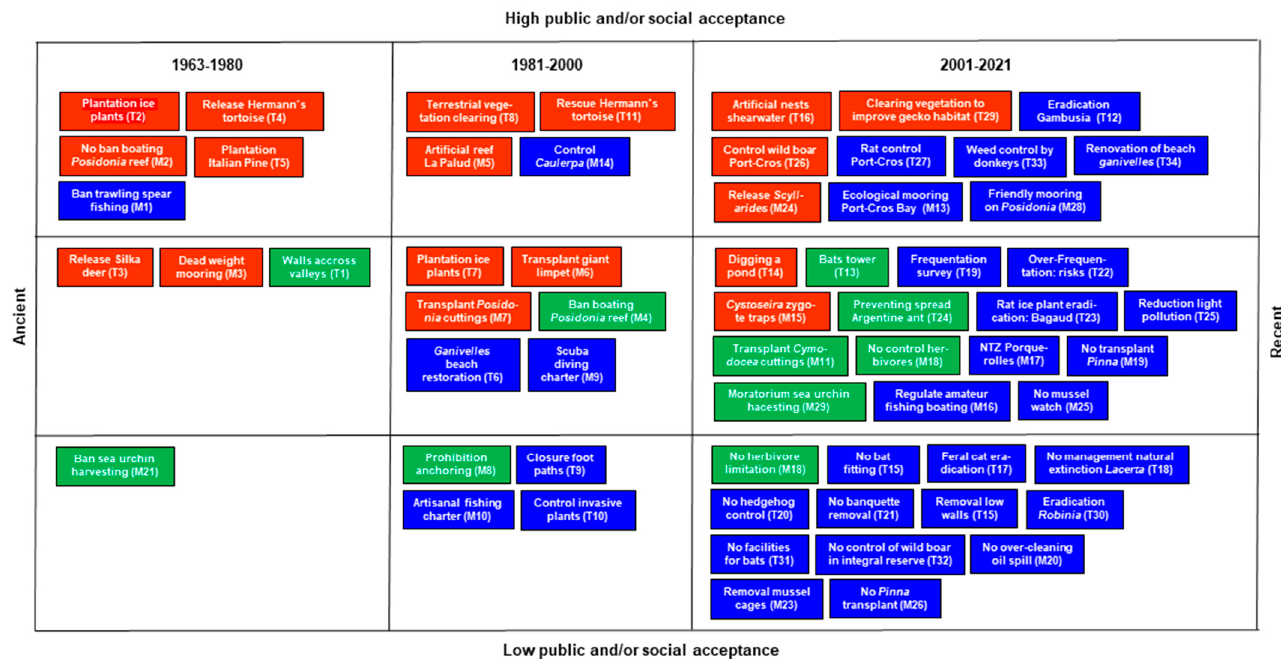
Figure 4. Some management operations within the core areas, terrestrial and marine, of the Port-Cros National Park, since its establishment (left to right), according to their public and/or social acceptability (top to bottom). The operations are in red, green and blue, according to their poor, medium and good compliance with current concepts of ecosystem-centred management, respectively. For details of terrestrial (T1 through T34) and marine (M1 through M29) operations, see Tables 1 and 2, respectively, in Boudouresque et al. [92], and Table 1 (in this article). Note that T3 was a decision external to the PCNP. M14 started in the 1990s, not in the 2000s, as is erroneously reported by Boudouresque et al. [92].